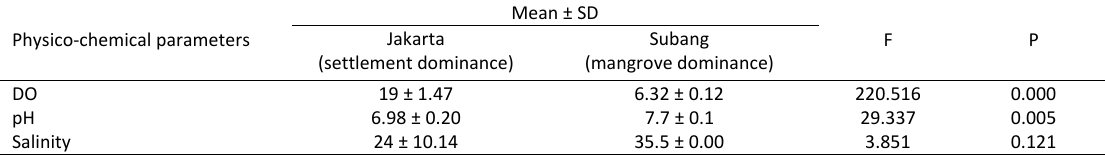
Table 2: Summary of the physico‐chemical parameters (DO, pH, salinity) mean ± standard deviation (SD) in Jakarta in the west (settlement dominance) and Subang in the east (mangrove dominance) on the West Java coast Indonesia